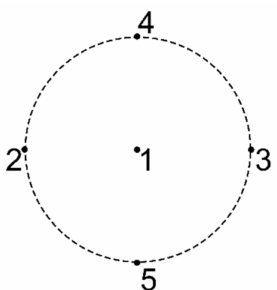
Figure 2. Example of a cluster of five assays and the order they were recorded in. The circle is 1cm in diameter. This is represented as a cross-hair symbol on object